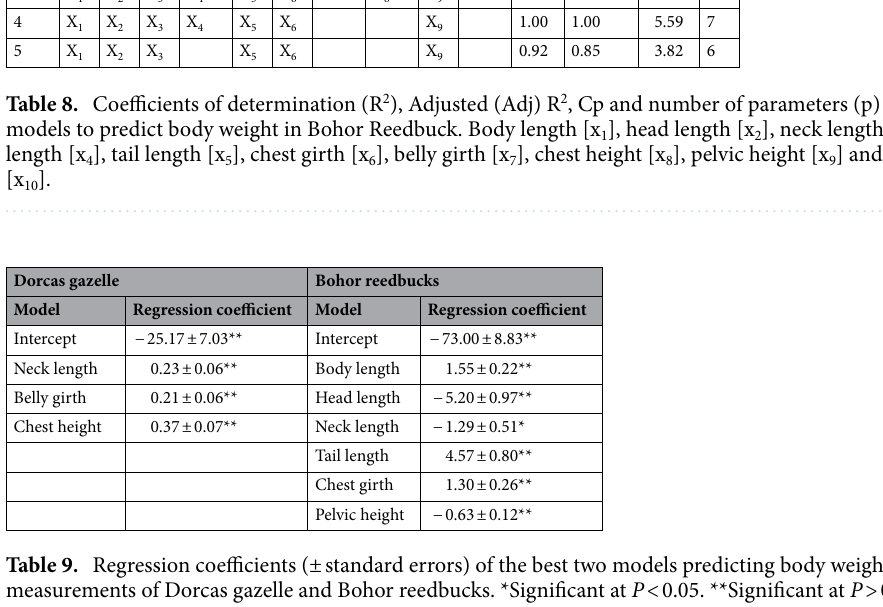
two models in the case of Dorcas Gazelles were the full model (model one) and that with belly depth excluded (model two). However, model four was the best model based on the adjusted value of R 2 and model eight was the best model based on C p criterion. It should be noted that model eight had the smallest number of predictors (e.g. neck length, belly girth and chest height). These three variables explained 82% of the total variation in body weight of Dorcas gazelle. The full model explained about 96% of the total variation in body weight, which means that the remaining seven variables explained about 14% of the total variation. Surprisingly, the adjusted R 2 value of model number eight is similar to the corresponding value of the full model. This suggests that model number eight is the best for estimating body weight of Dorcas Gazelles. The best models predicting body weight from body measurements in Bohor Reedbucks are presented in Table 8. Based on R 2 and its adjusted version, the full model was as good as model number two, three and four. However, the fifth model should be the best model based on the C p criterion. This model with six parameters explained 92% of the total variation in body weight of Bohor Reedbucks, while the remaining four explained about 8%. It is suggested that one may use this model for estimating body weight of Bohor reedbucks. Table 9